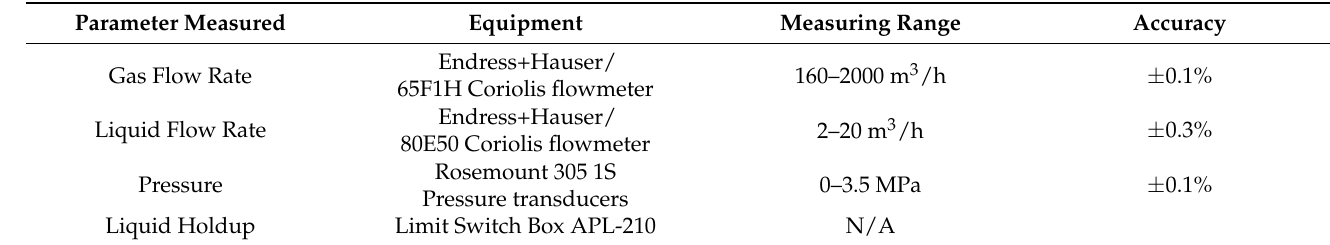
Figure 2. Experimental setup—( a ): experimental rig in vertical position (photo); ( b ): schematic representation of rig; ( c ) dimensions of test section. (Adopted from Ribeiro et al., [4], with permission from Taylor and Francis). Table 1. Details of experimental apparatus employed.